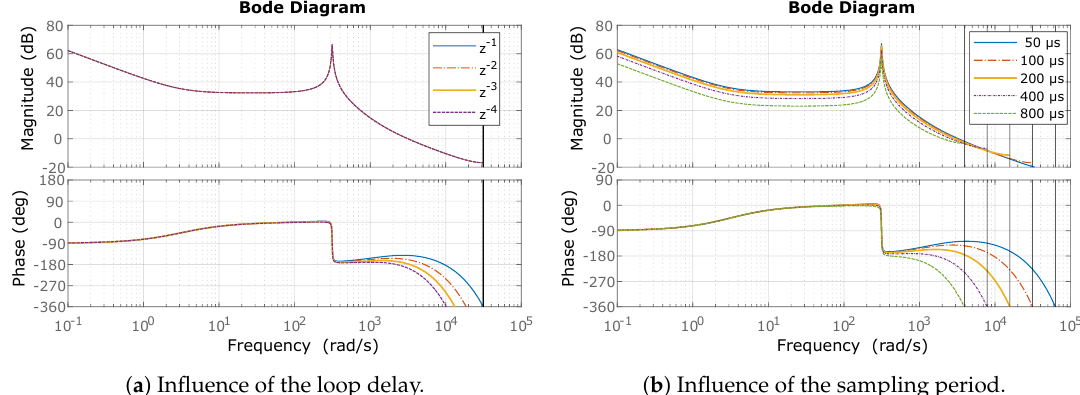
Figure 5. Open-loop Bode diagram of the plant with